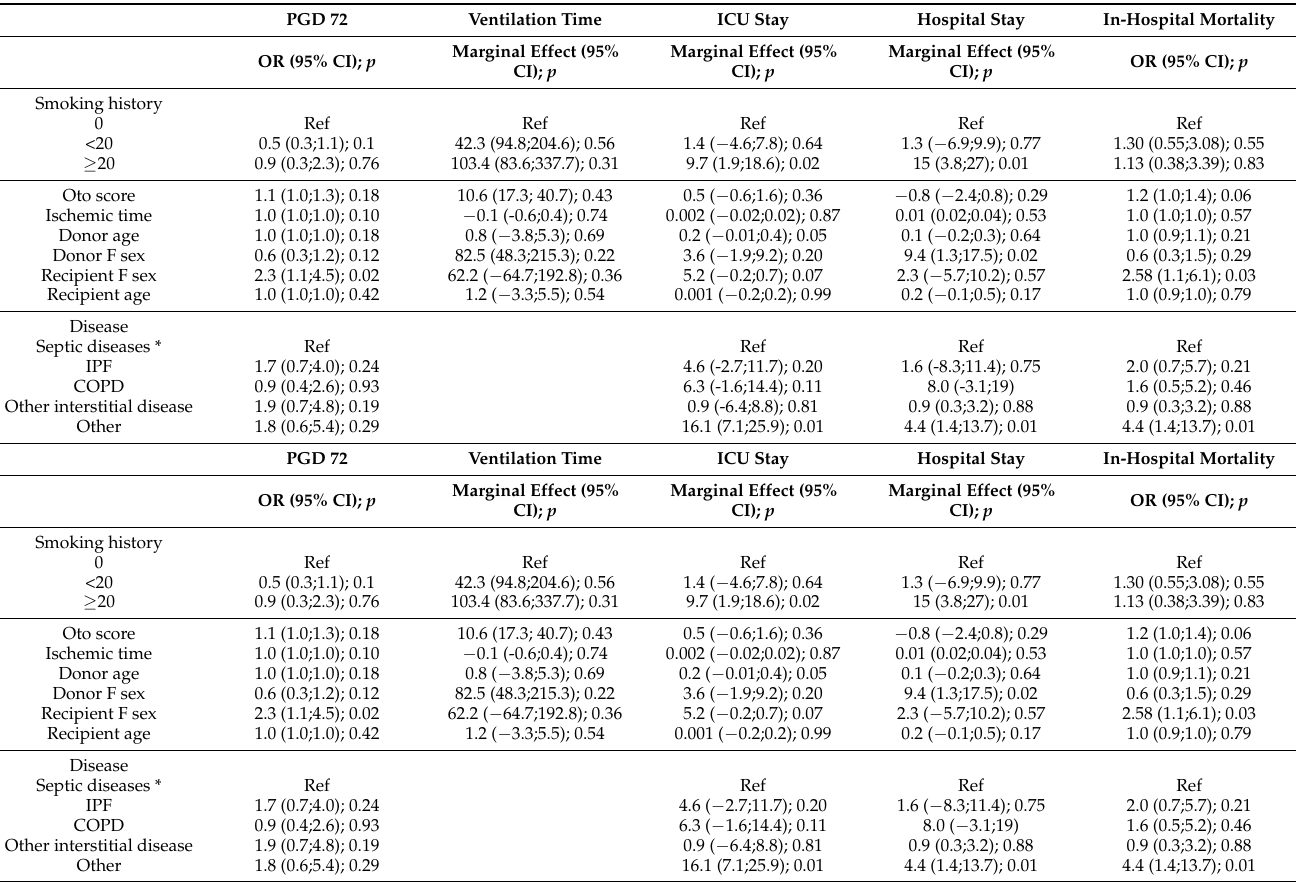
Table 3. Multivariate analysis of variables associated with early post-transplant outcomes 1